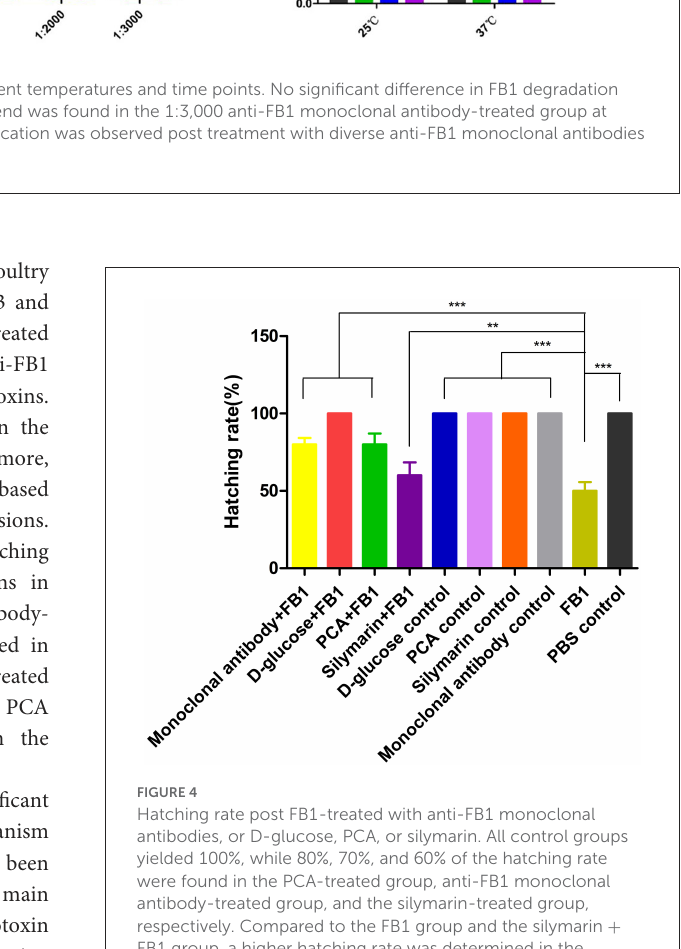
antibodies. In a previous study on mice, 9C11E6 monoclonal antibodies (mAb) against FB1 were generated from hybridoma cell lines, and the amounts causing 50% inhibition